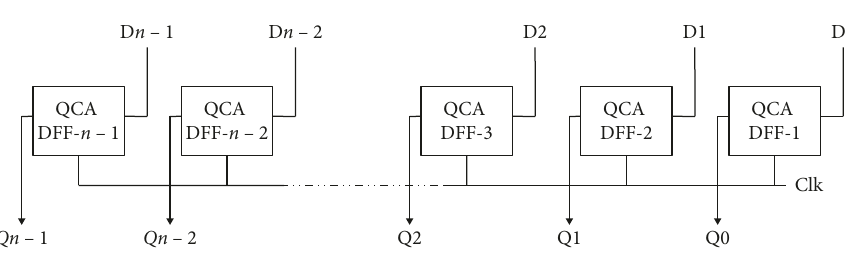
Figure 12: Block diagram of the proposed 8-bit PIPO shift register.